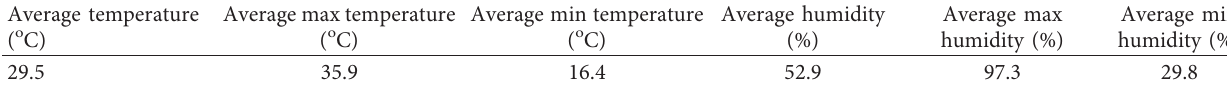
Table 1: Average temperature and humidity in the greenhouse.